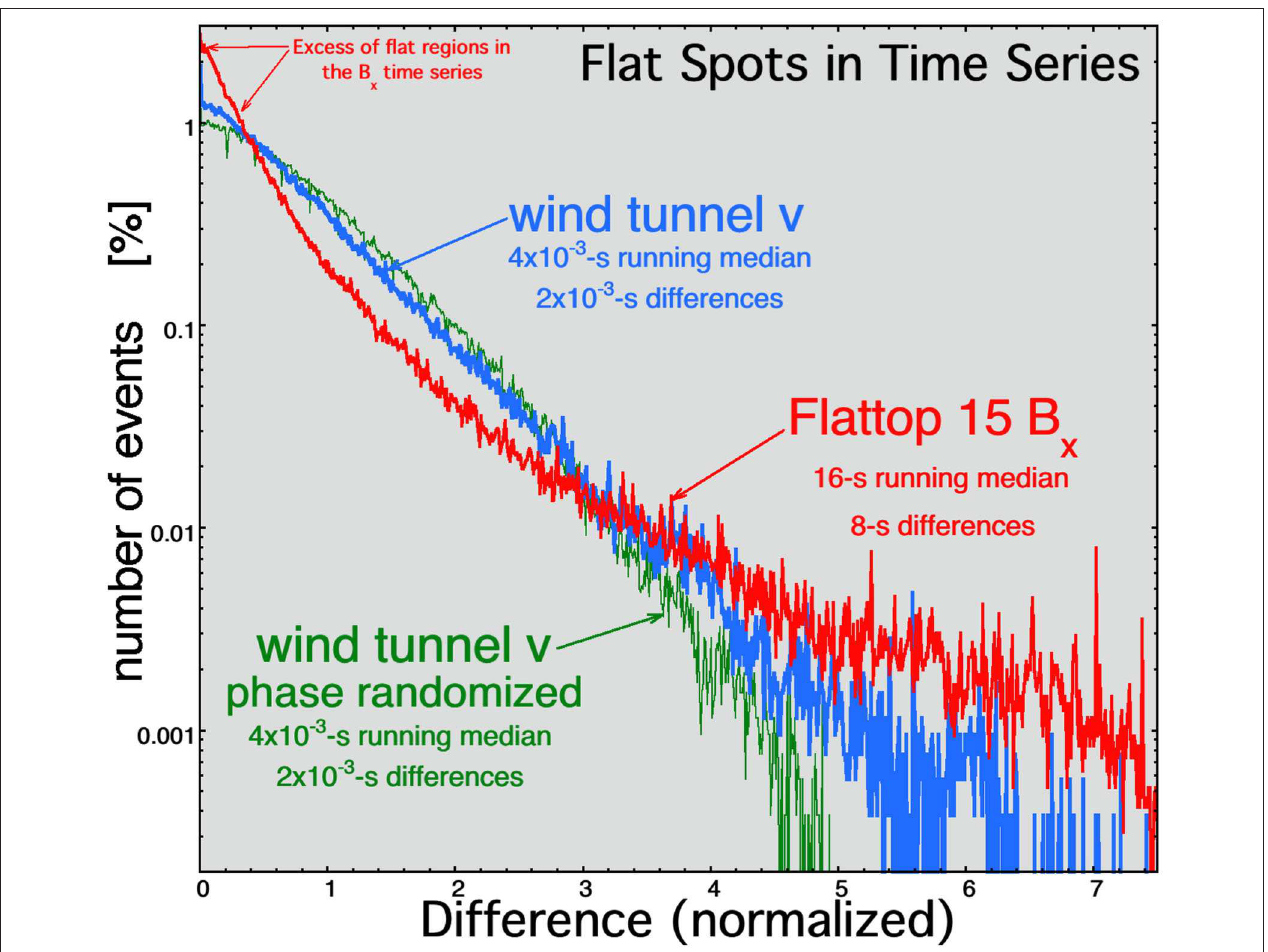
FIGURE 11 | The normalized distribution of 2 × 10 − 3 -s differences of the streamwise velocity v in the wind tunnel Navier–Stokes turbulence (blue curve) and the normalized distribution of the 8-s differences of the radial component of the magnetic field B x for the Alfvénic solar wind fluctuations of Flattop 15 (red curve) calculated after 4 × 10 − 3 -s and 16-s running medians were applied to the time series. The green curve is the normalized distribution of differences of the streamwise wind-tunnel velocity v after the wind-tunnel time series was (1) phase randomized and then (2) processed with a 4 × 10 − 3 -s running